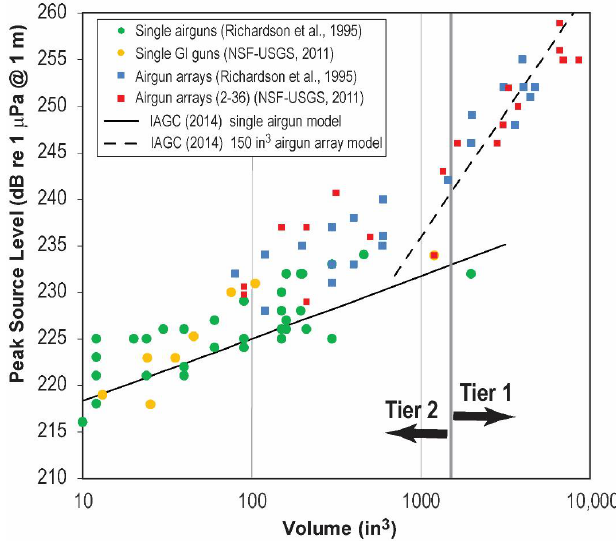
Figure 3. Compilation of source-level data on single airguns and airgun arrays, primarily from [24,25]. The black solid and dashed lines correspond to modeled values for single airguns and an array of 150 in 3 airguns, respectively, based on [26] . Tier 1 indicates airgun surveys with total vol- ume of 1500 in 3 or greater and/or 12 airguns or more. All other airgun surveys are designated as Tier 2. Note that rms source level has no physical meaning for impulsive sources such as airguns, so the peak metric is used, as explained in the text.